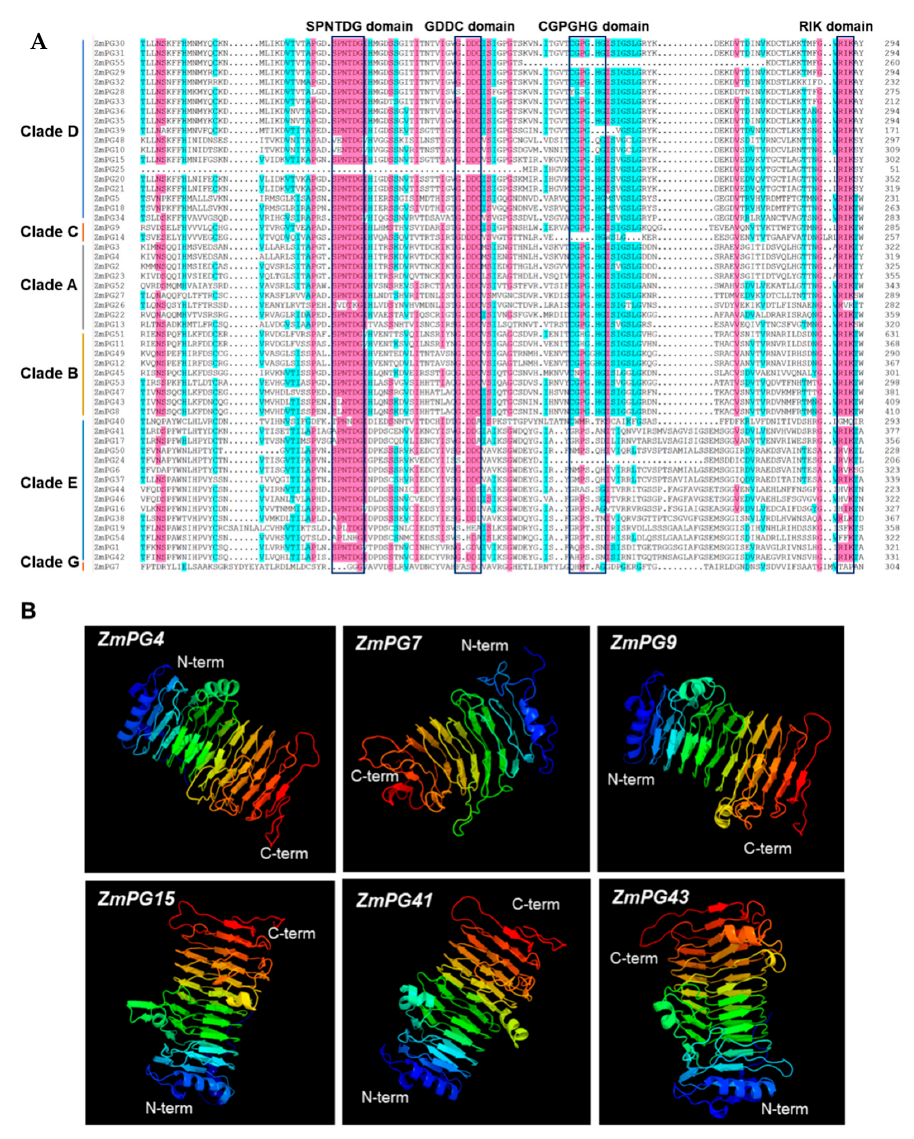
Figure 6. Conserved domain and structural analysis of ZmPGs. ( A ) Amino acid sequences alignment of four conserved domains in ZmPGs. The conserved sequences of the four conserved domains are shown at the top. The annotations on the left indicate the different classifications of PGs. ( B ) Three- dimensional structures of six representative ZmPG